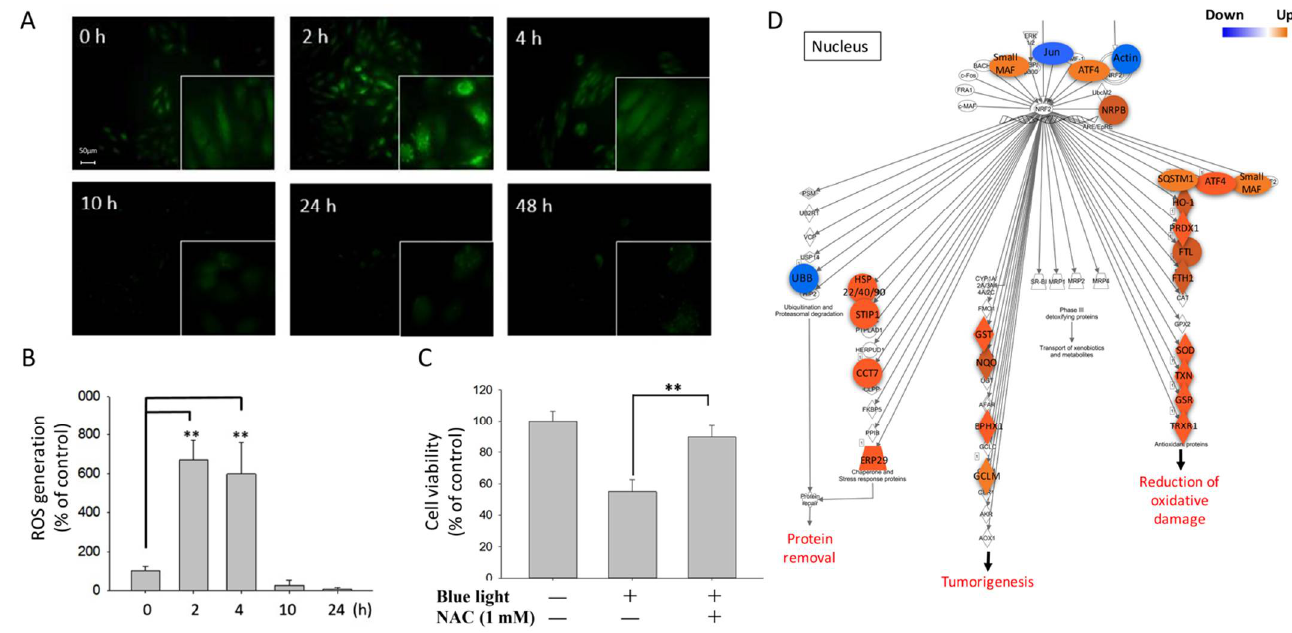
Figure 2. ROS generation in ARPE-19 cells induced by blue light. ( A ) Blue-light-induced ARPE-19 cell ROS (reactive oxygen species) generation was detected by using DCFDA staining and immunofluorescence microscopy. Blue light induction from 0 to 48 h (magnification: 40 × ; enlarged: 200 × ). ( B ) Quantitative results of ROS generation induced by blue light within 48 h (** p < 0.01). ( C ) MTS assay was used for cell viability determination of blue-light-induced ARPE-19 cell death; the ROS-specific inhibitor NAC (1 mM) was used to inhibit ROS generation (** p < 0.01). ( D ) RNA-Seq and IPA of the ROS regulation pathway and molecules involved in ARPE-19 cells affected by blue light exposure. Blue: decreased gene expression; orange: increased gene expression.